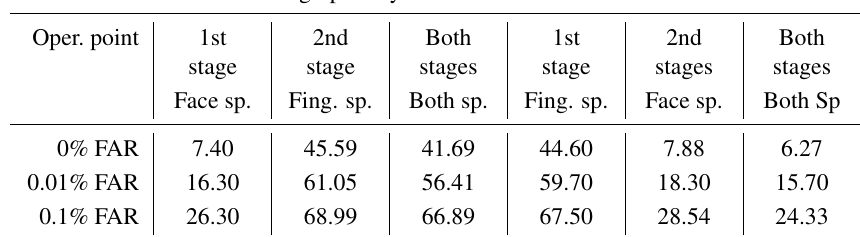
Table 1. FAR (%) of the face–fingerprint system in parallel fusion mode, with the sum, weighted sum, and LLR rules (top), and face–fingerprint and fingerprint–face systems in serial fusion mode (bottom), when either the fingerprint, the face or